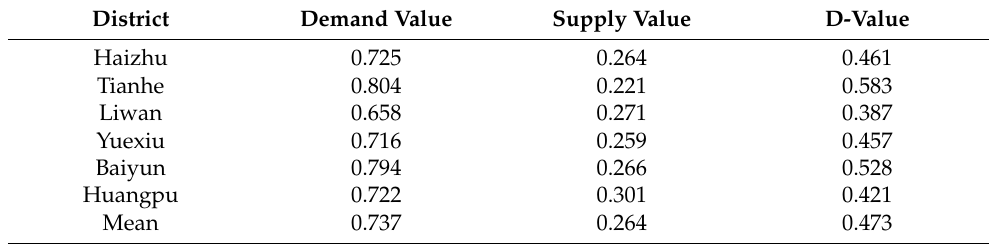
Table 3. Supply and demand composite value of Green Stormwater Infrastructure.